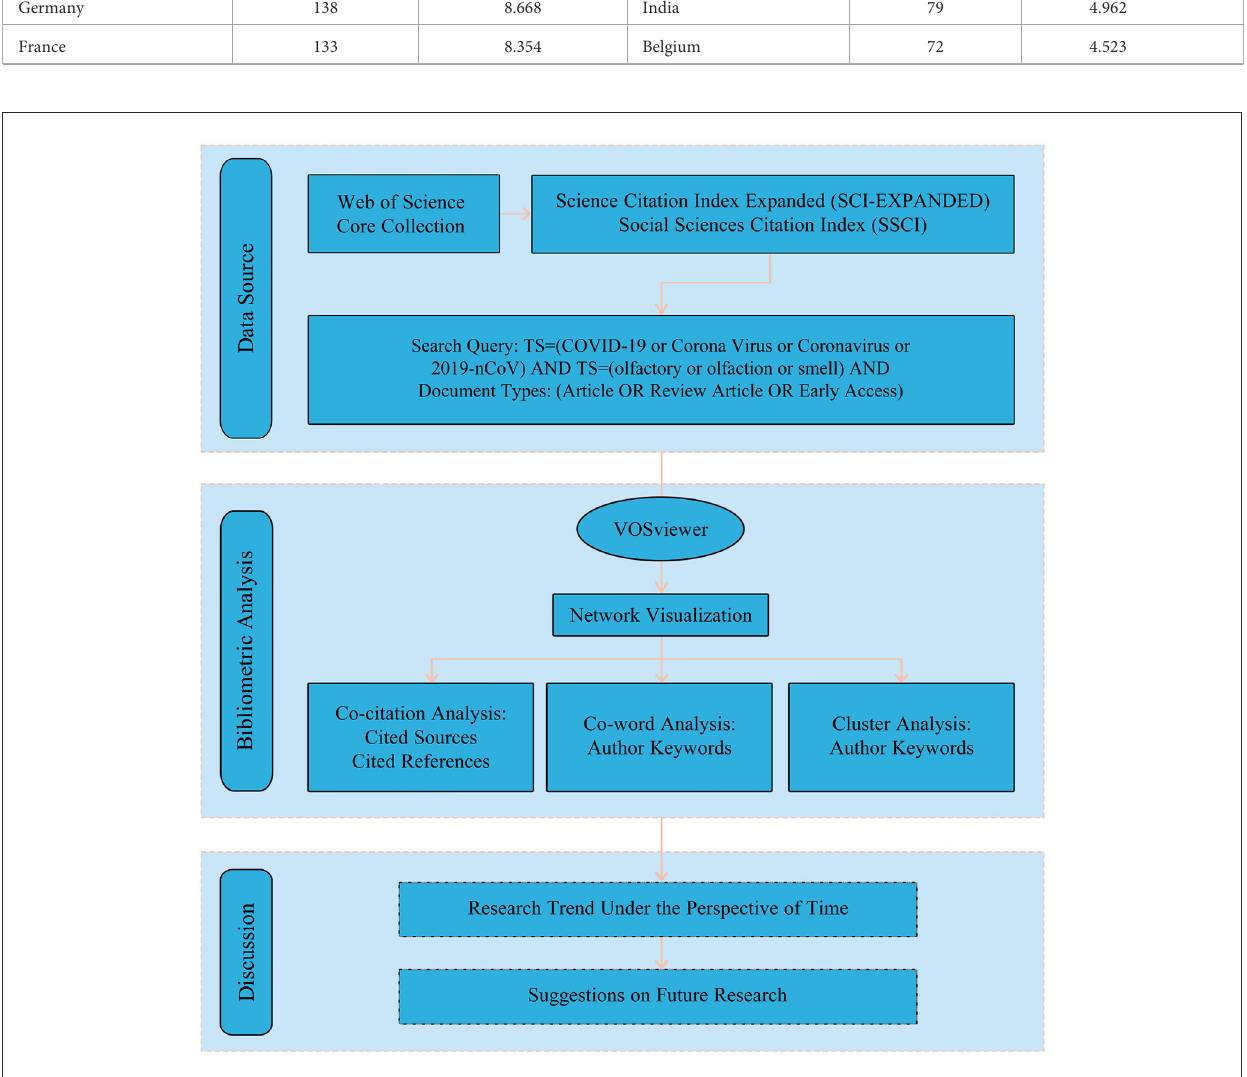
FIGURE1 The structure of this